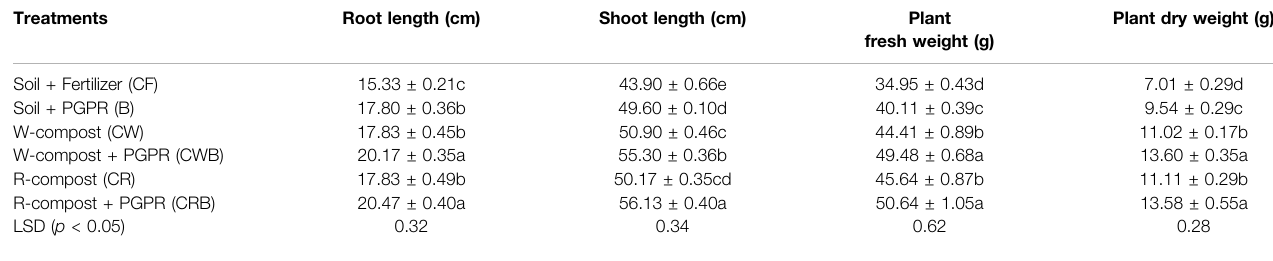
TABLE 3 | Individual impact of wheat and rice compost with/without PGPR consortium on the morphological growth of chili in pots.